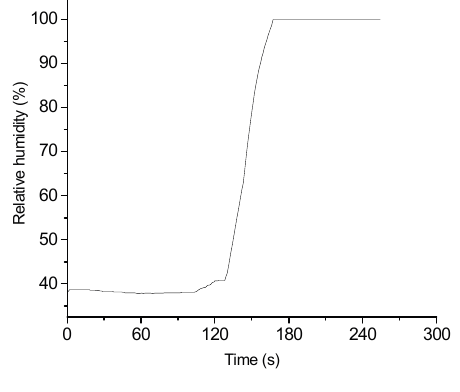
Figure 7. Environmental control performance of humidity in the cooling